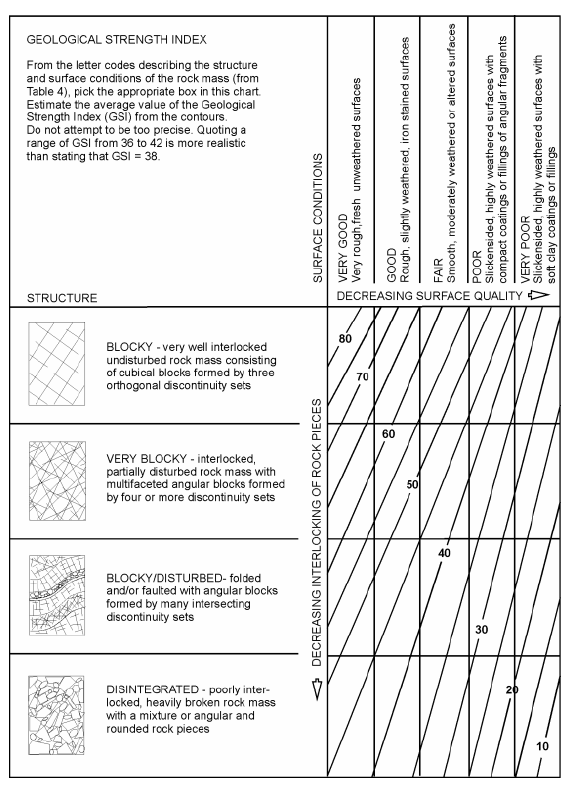
Figure A1. GSI chart for jointed rock masses [21].